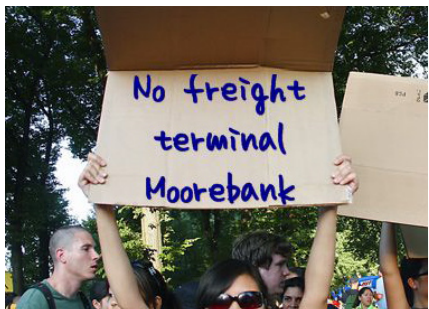
Figure 12. Australian residents in Liverpool protest proposal to build a freight terminal in nearby Moorebank, New South Wales